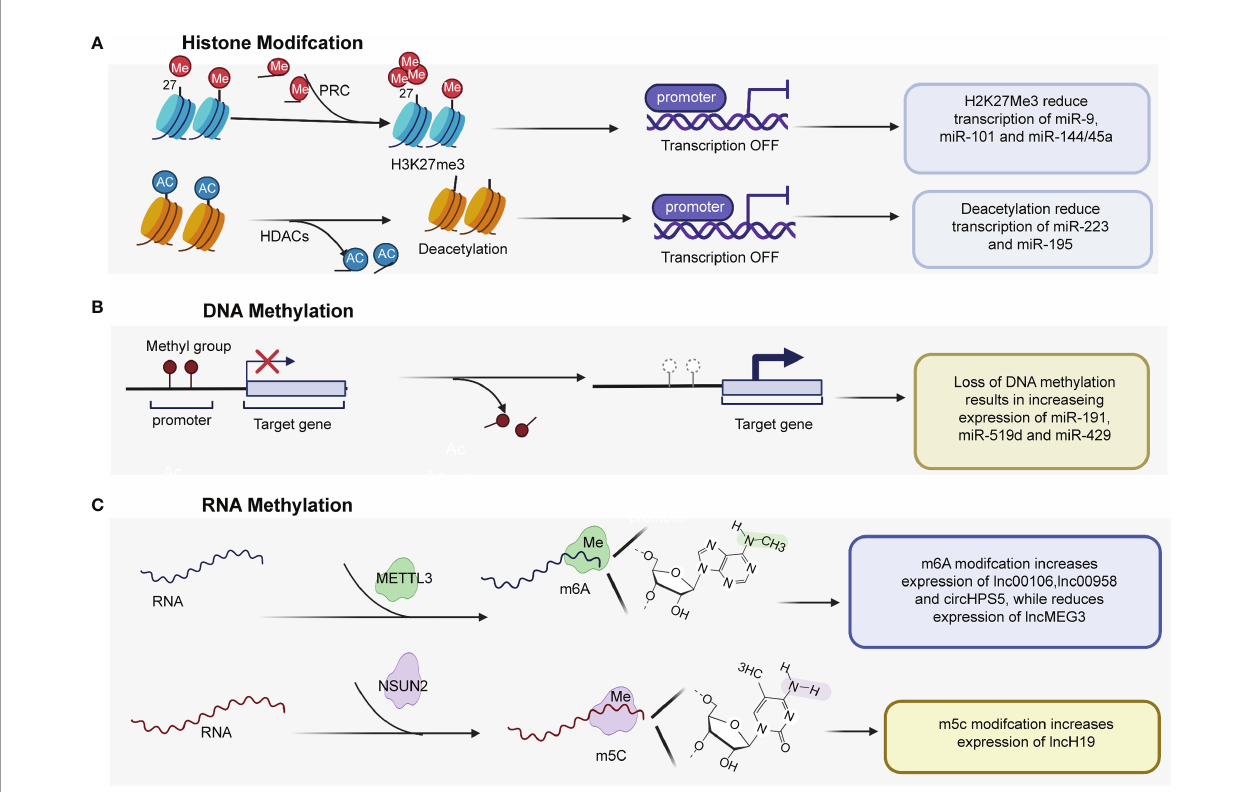
FIGURE 1 | Epigenetic mechanisms play important roles in regulating the expression of ncRNAs. (A) H3K27me3 mediated by PRC2 regulates miRNA expression by regulating the promoters of miR-9, miR-101, and miR-144/45a. HDACs are recruited to the miR-223 and miR-195 promoter, and histone deacetylation contributes to genes downregulation. (B) Several tumor-promoting miRNAs have been found to be upregulated by promoter DNA hypomethylation. (C) m6A methyltransferase METTL3 catalyzes m6A modi fi cation of some lncRNAs and circRNA at the posttranscriptional level, promoting the expression of lnc00106, lnc00958 and cirHPS5, while reducing lncMEG3 expression level. PRC2, Polycomb repressive complex 2; HDACs, histone deacetylases; miR, microRNA; H3K27me3, trimethylation of histone H3 at lysine 27; METTL3, Methyltransferase-like 3.